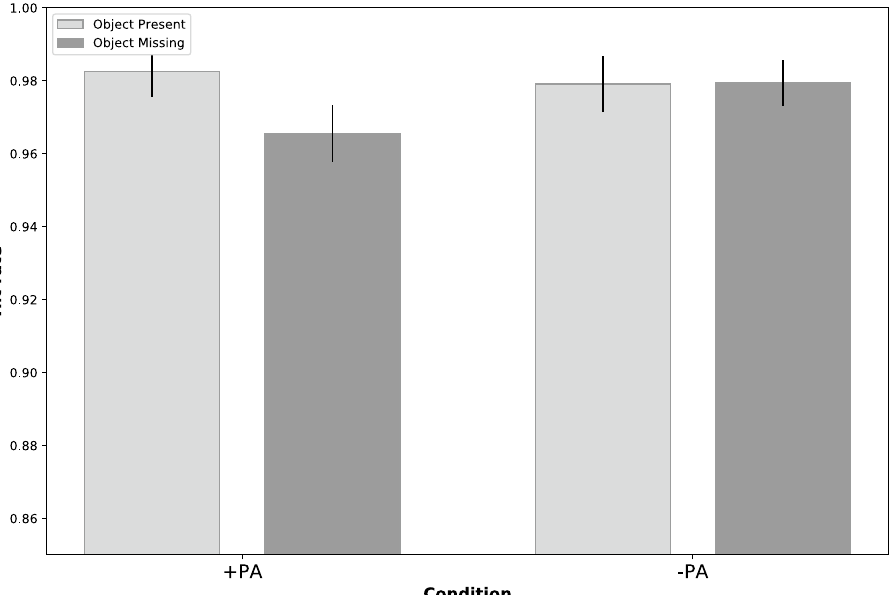
Figure 3. Hit rate results by conditions. On the X-axis there are the two conditions: + PA, when the observer’s perceived to have access to the object’s potential location t, and −PA where the observer is perceived as having no access to it. The Y-axis shows hit rates. Error bars indicate 95% CI in each